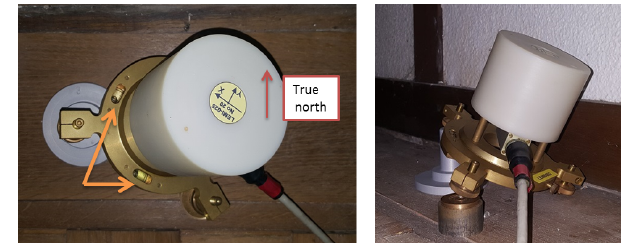
Figure 3. LEMI-025 installed in the Dourbes magnetic observatory. The red arrow indicates the true north direction. The orange arrows highlight the bubble-levels saturation.